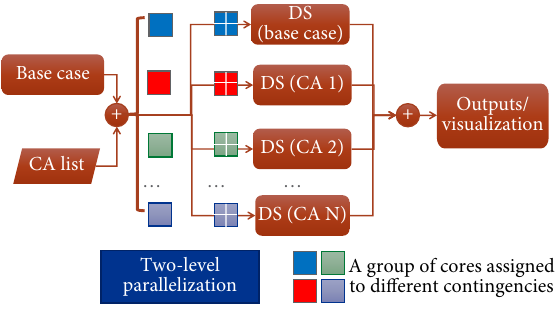
Fig. 9 A two-level task manager example for dynamic security